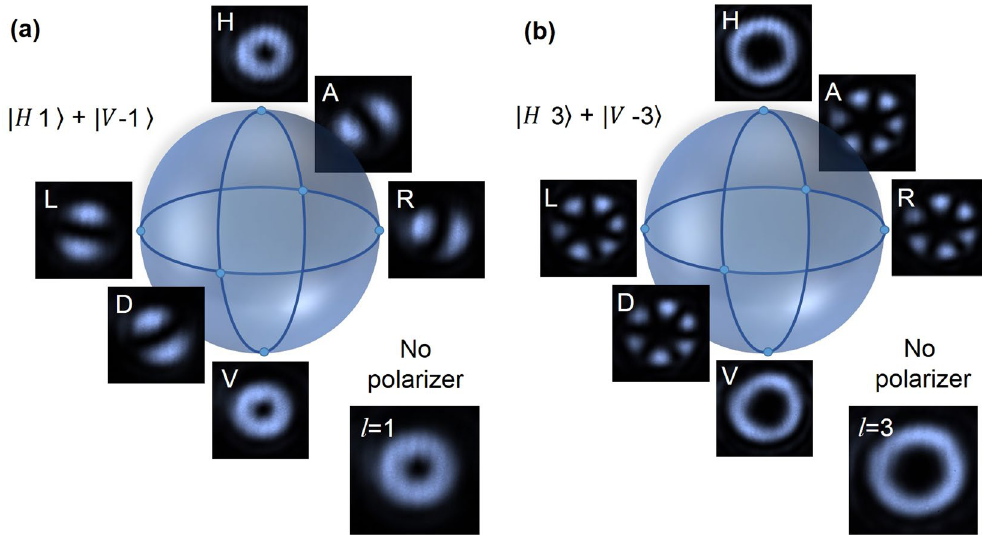
Figure 3. Intensity profiles of the non-separable states of the pump beam for two different OAM modes. Depending on the projection of the beam in different polarization states, | H 〉 , | A 〉 , | R 〉 , | V 〉 , | D 〉 and | L 〉 (as shown by the white letters on the images) on the Poincaré sphere, the mode pattern of the beam recorded by the CCD camera change to different points on LG-Bloch sphere for ( a )